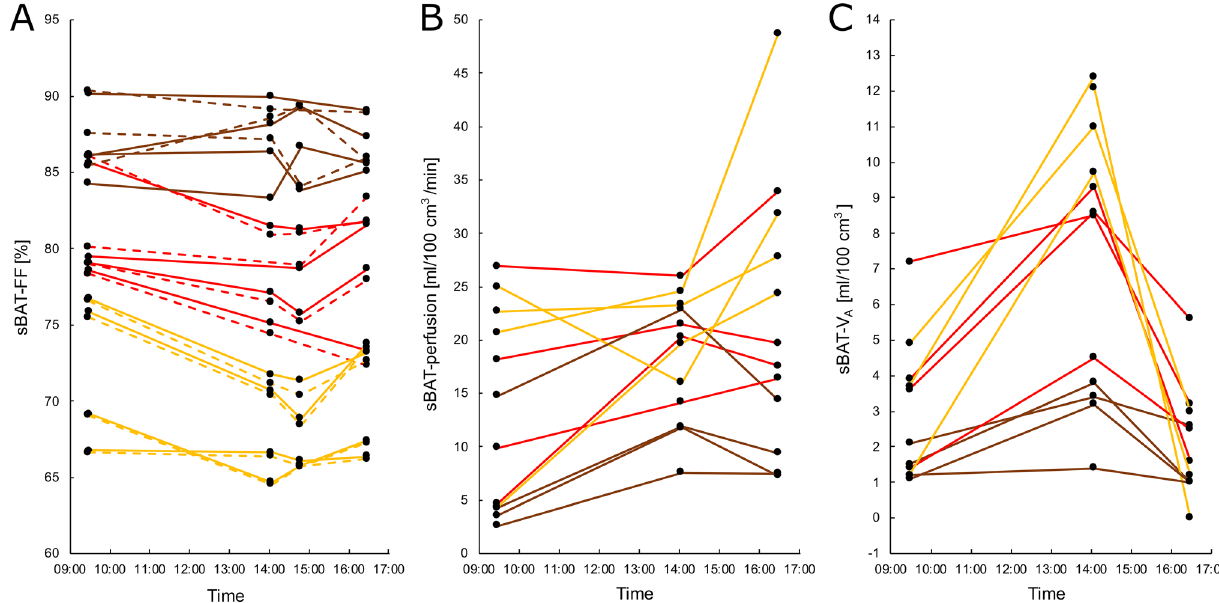
Figure 5. Changes in (A) FF, (B) perfusion and (C) V A within sBAT of individual subjects over time during the Cooling-reheating protocol. Solid lines, sBAT. Dashed lines, sBAT HI . Yellow, red and brown correspond to the four subjects with the highest, intermediate and lowest sBAT-MR glu , respectively. In the sBAT-FF measurement, cold scan 1 was missing for one subject and cold scan 2 for two other subjects. A fourth subject did not show any sBAT HI . In the sBAT-V A measurement, the baseline scan was missing for one subject and the reheated scan for another subject. Time, approximate mean session time for all